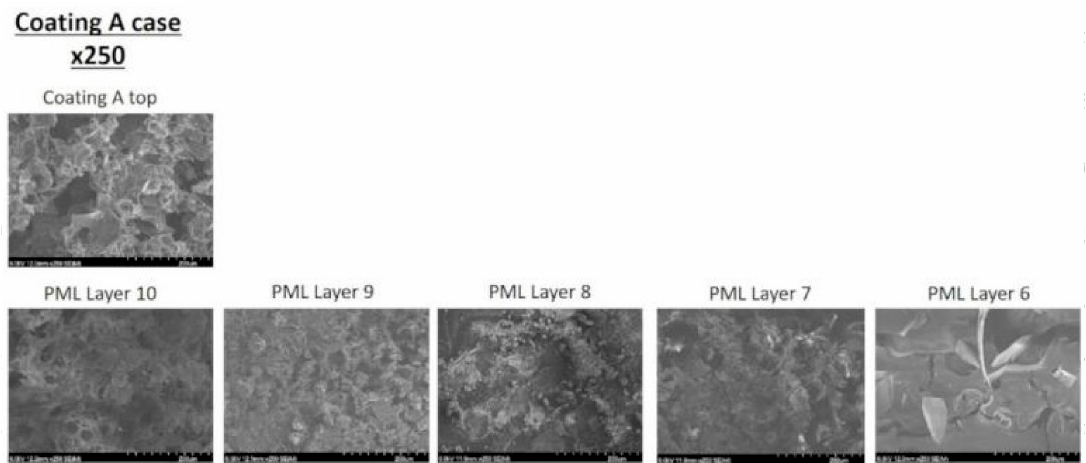
Figure A1. SEM pictures comparing IC-A char to IPML-A chars (taken from layers 10 to